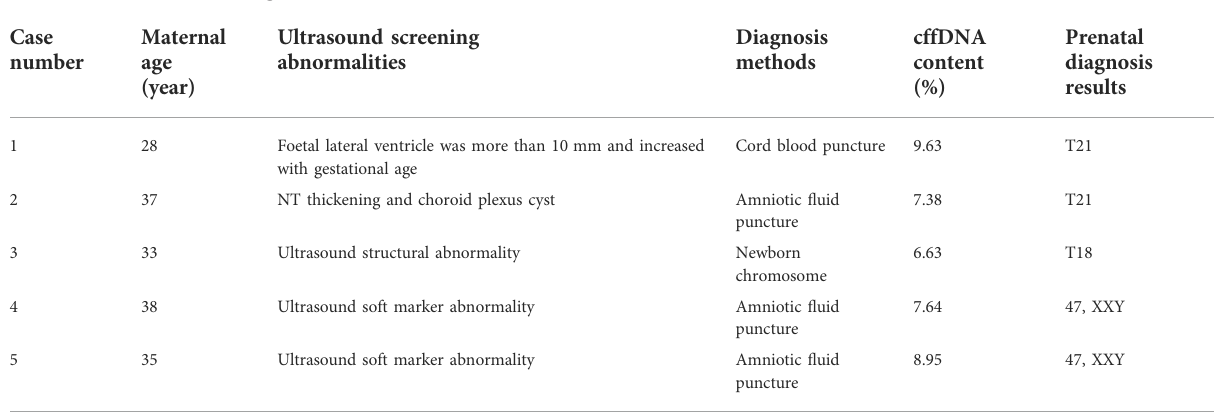
TABLE 3 Details of the false-negative NIPT